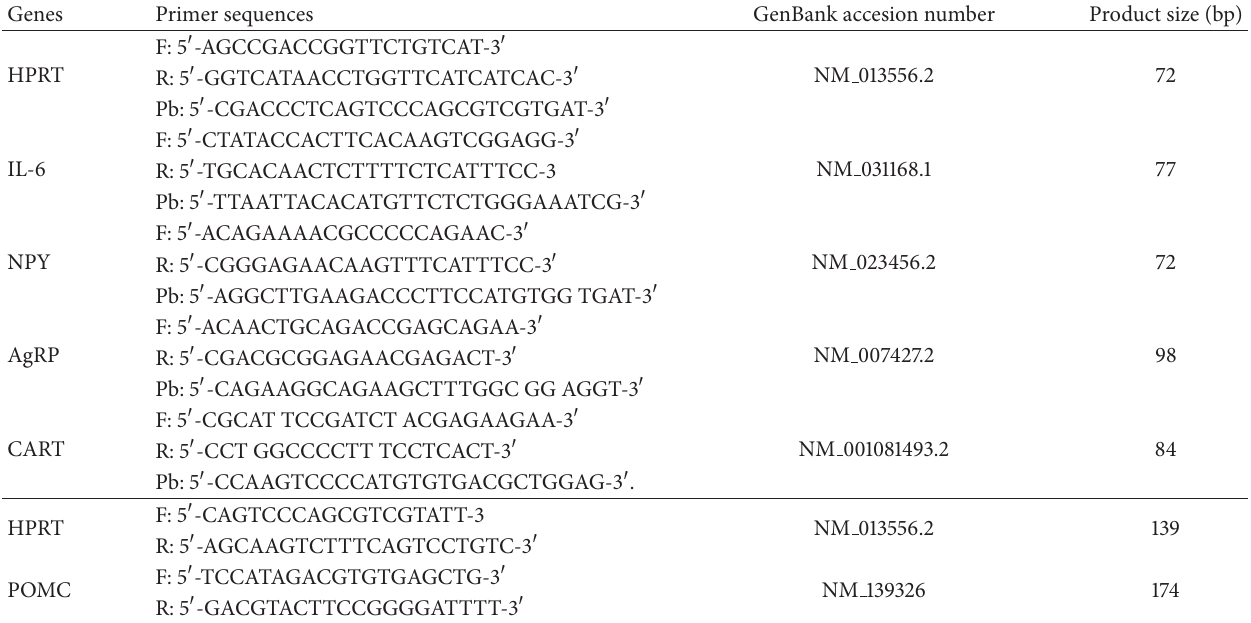
Table 2: Primers and probes used for